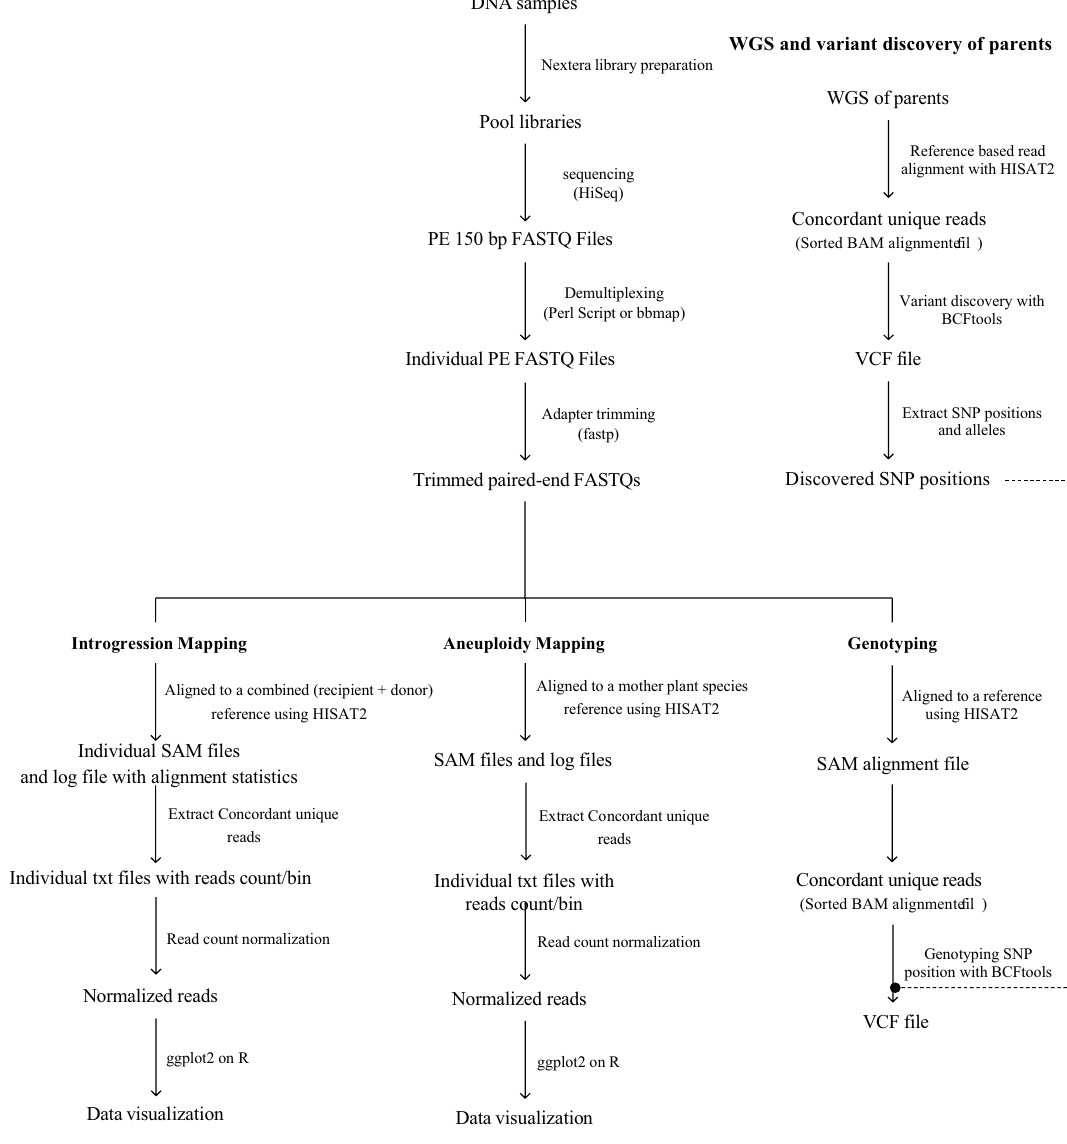
Figure 1. Skim-seq processing pipelines using sequence data generated from optimized Nextera library preparation followed by applications including introgression mapping, aneuploidy determination, and single nucleotide polymorphism (SNP) discovery and